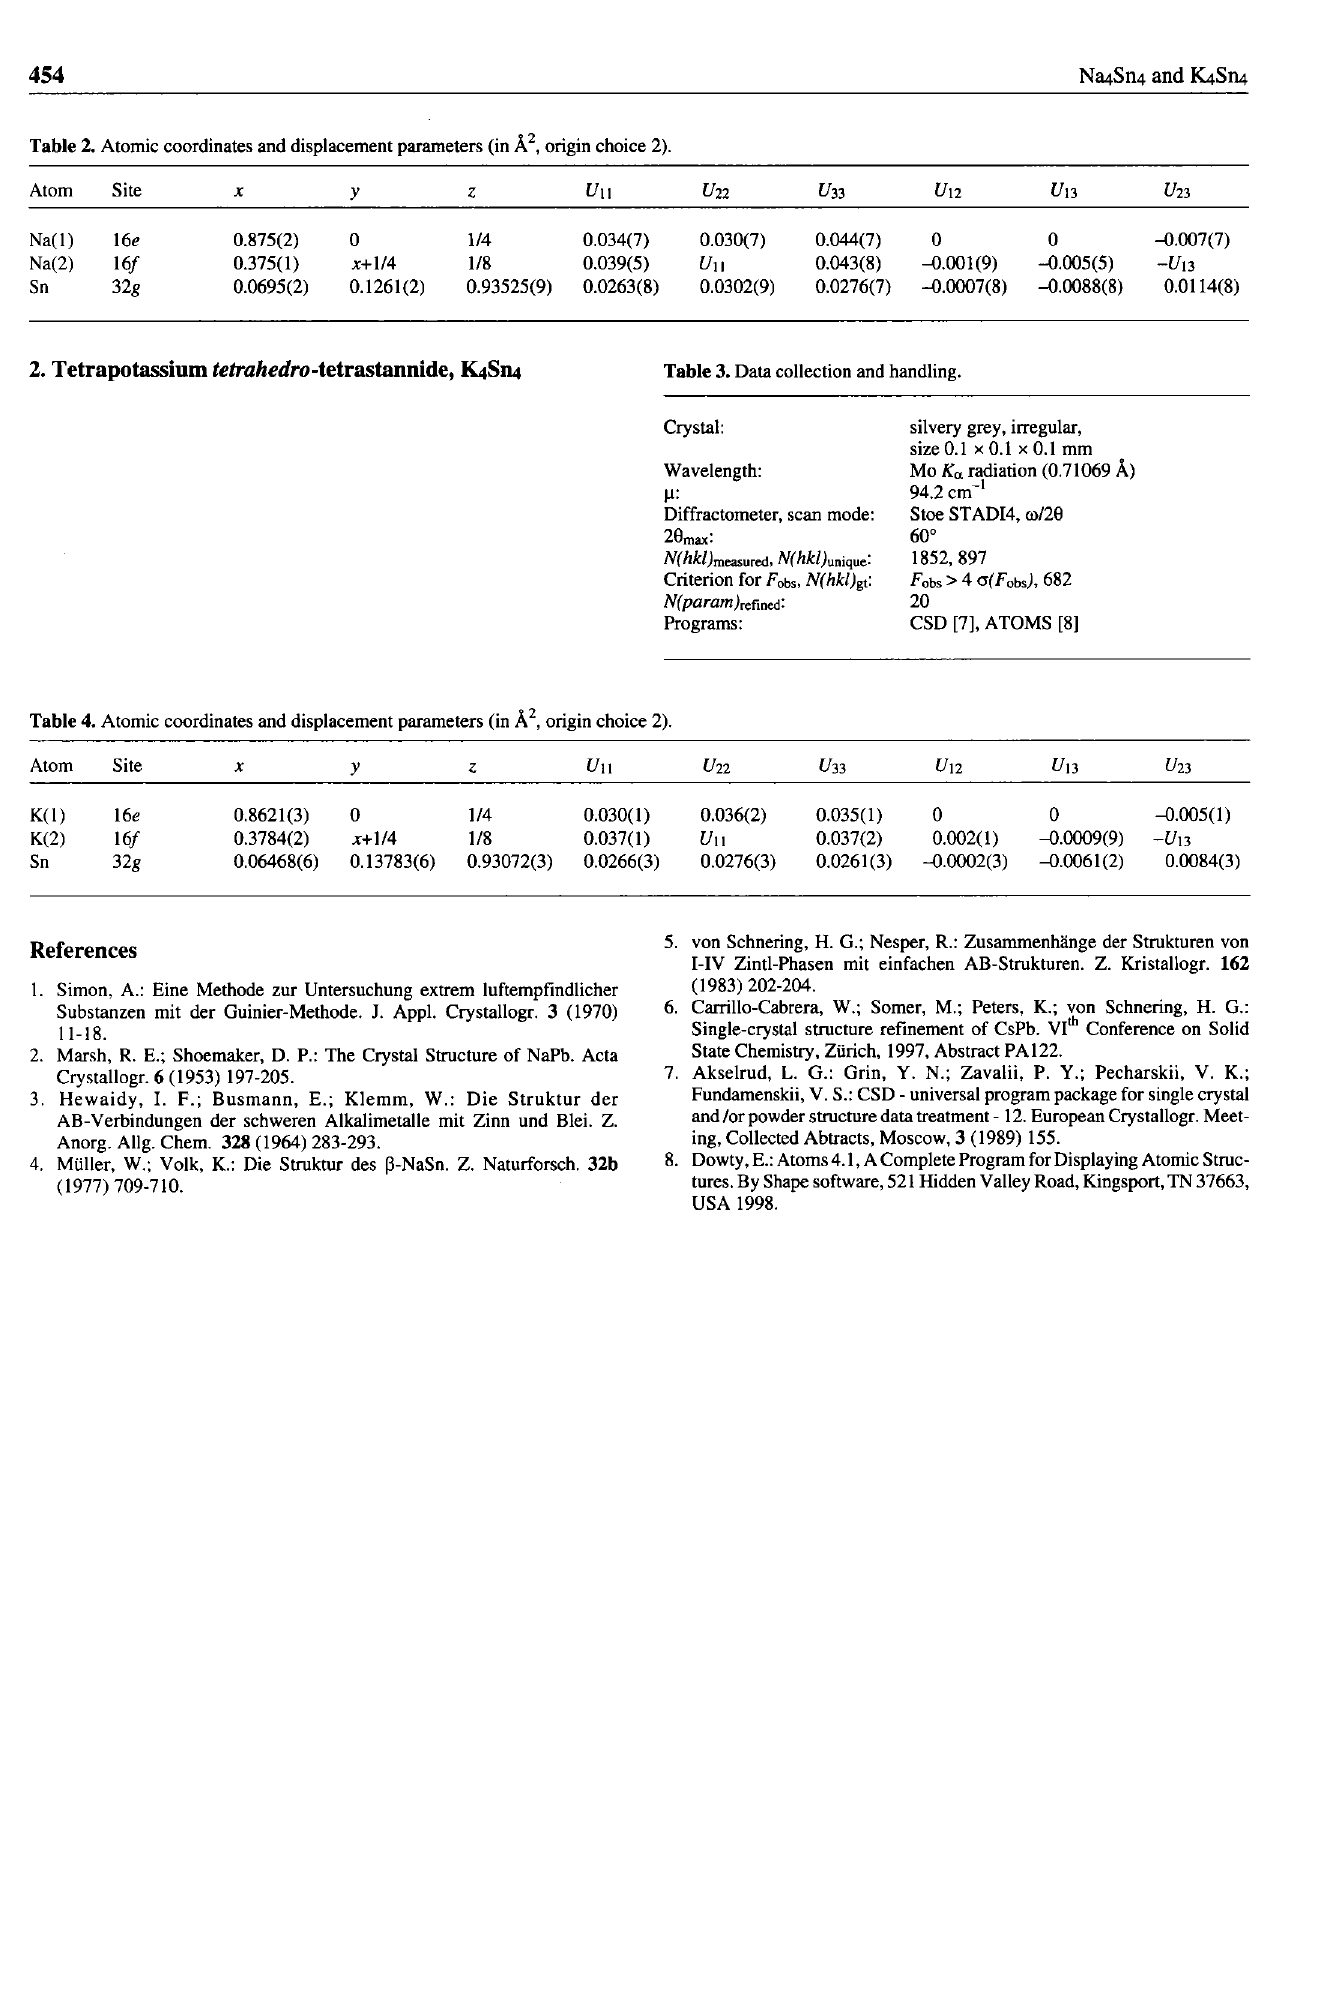
Table 2. Atomic coordinates and displacement parameters (in Ä 2 , origin choice 2).